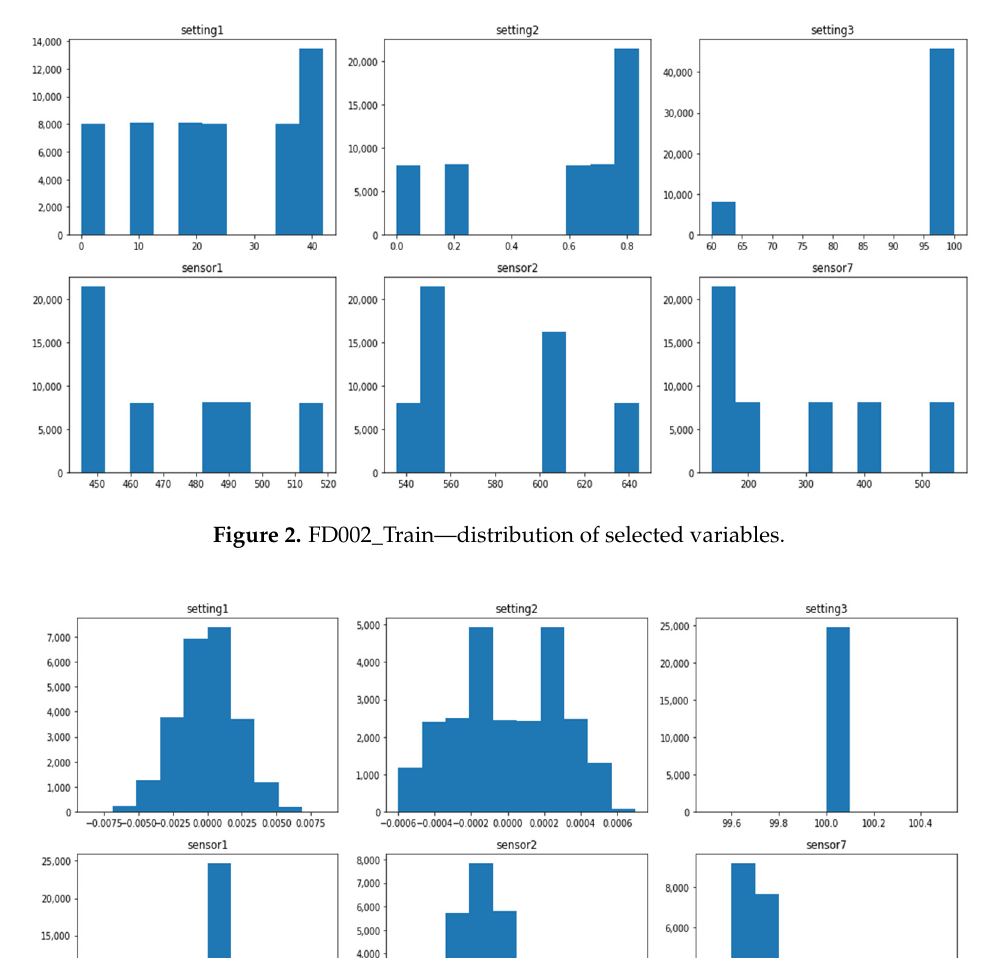
Figure 4. FD004_Train—distribution of selected variables.